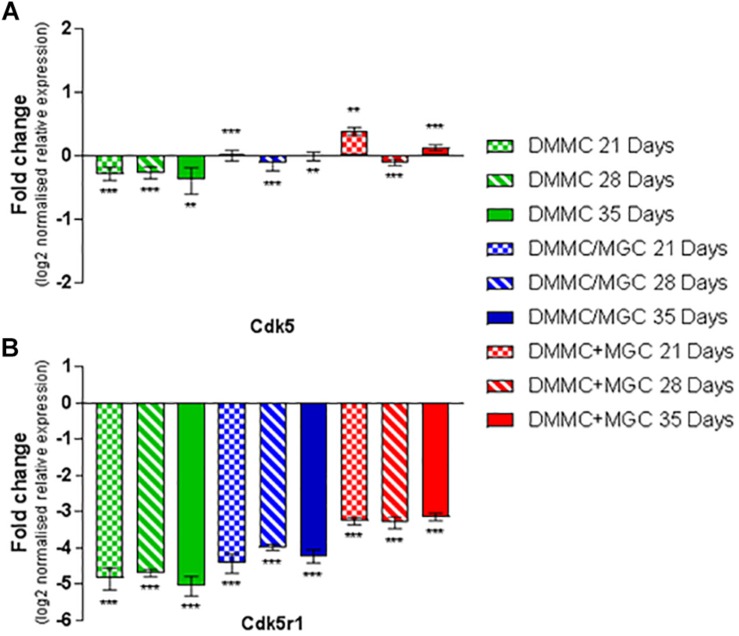
Comparisons of Cdk5 (A) and Cdk5r1 (B) gene expression relative to healthy adult mouse brain extract. Statistical comparisons relative to reference brain extract shown on graph only (∗∗p < 0.01, ∗∗∗p < 0.001).